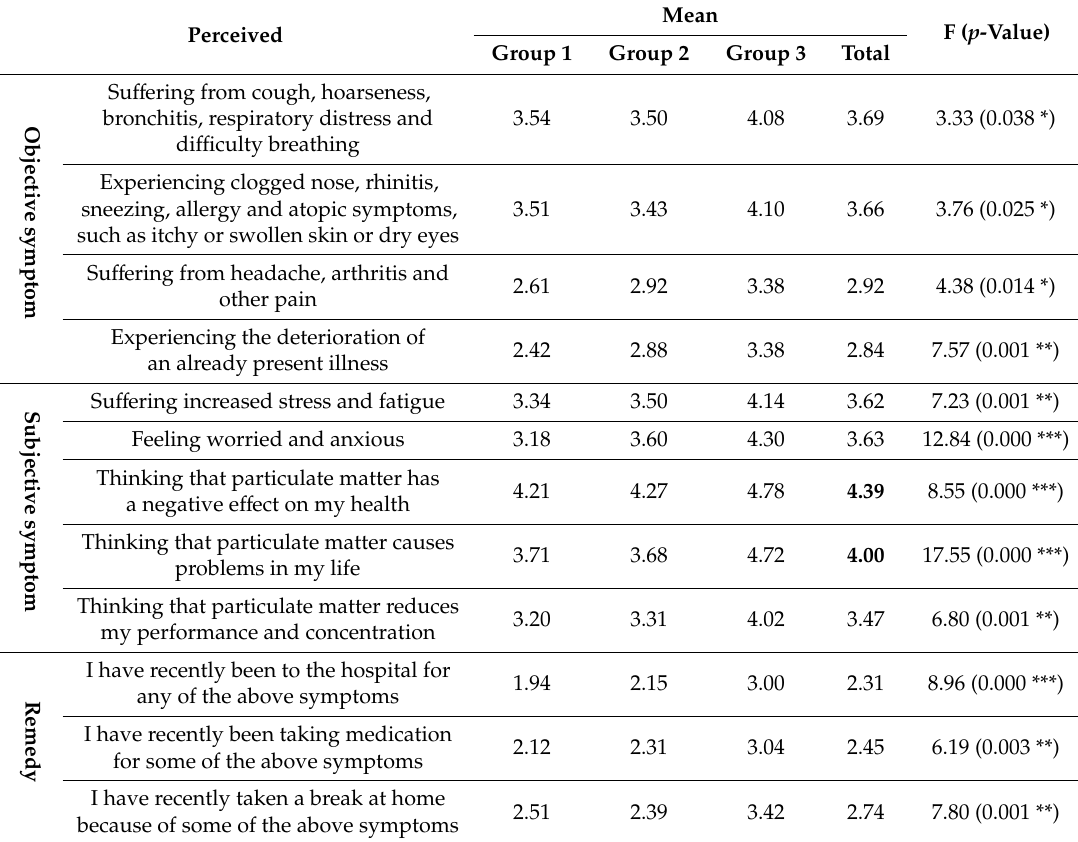
Table 8. Health-related symptoms experienced by residents as a consequence of particulate matter.